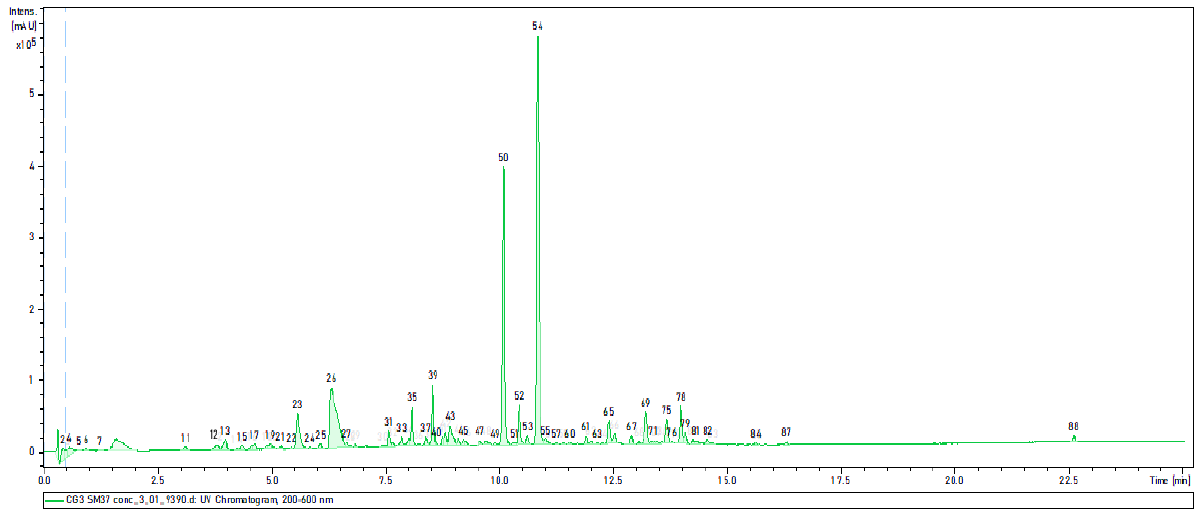
Figure 2. LC-UV-MS profile of crude extract prepared from the culture of strain CG3 in SM.